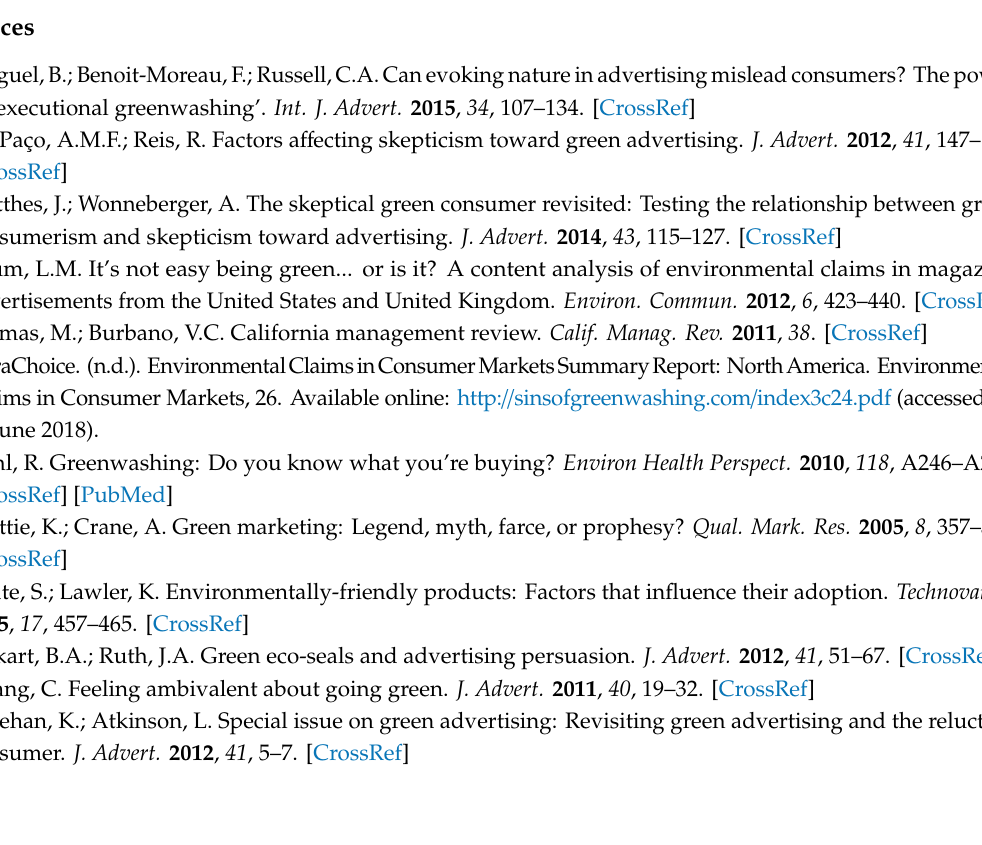
Figure S1: Overview of the nonverbal / pictorial design elements; Figure S2: Di ff erences between low and high environmental consciousness consumers in their focus of attention